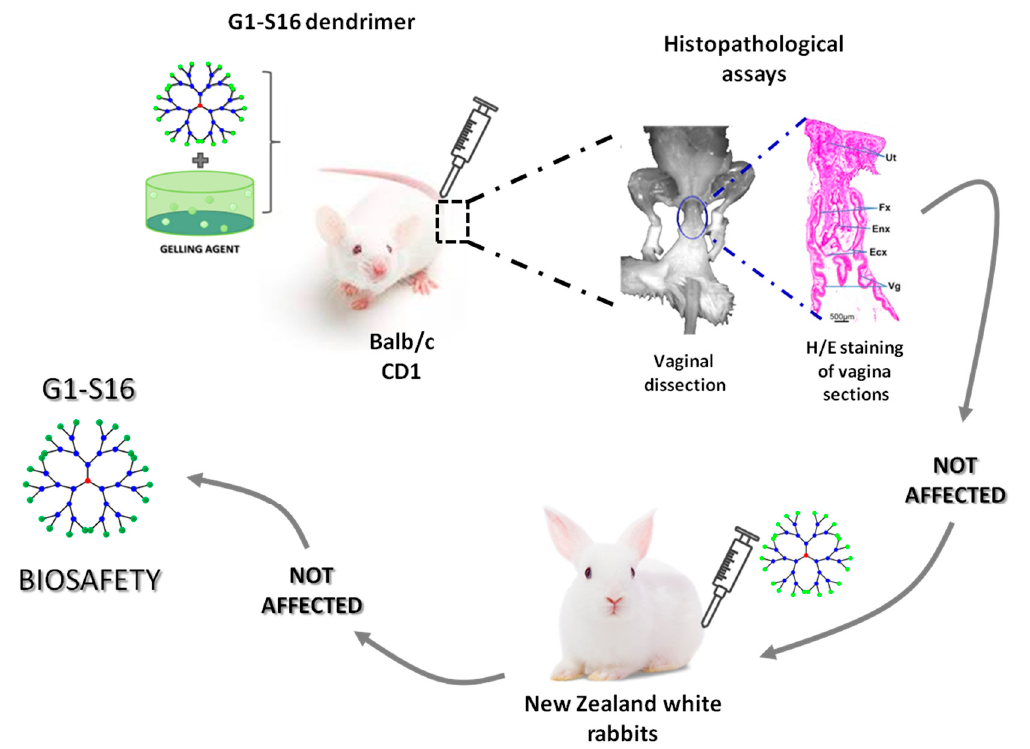
Figure 4. Summary of the main in vivo results obtained from the G2-S16 anionic carbosilane dendrimer study. This G2-S16 dendrimer has been demonstrated to be safe in several in vivo models such as BALB/c or CD1 female mouse, as well as in New Zealand white rabbits at different concentrations [18,85,91]. H/E: hematoxilin/eosin.